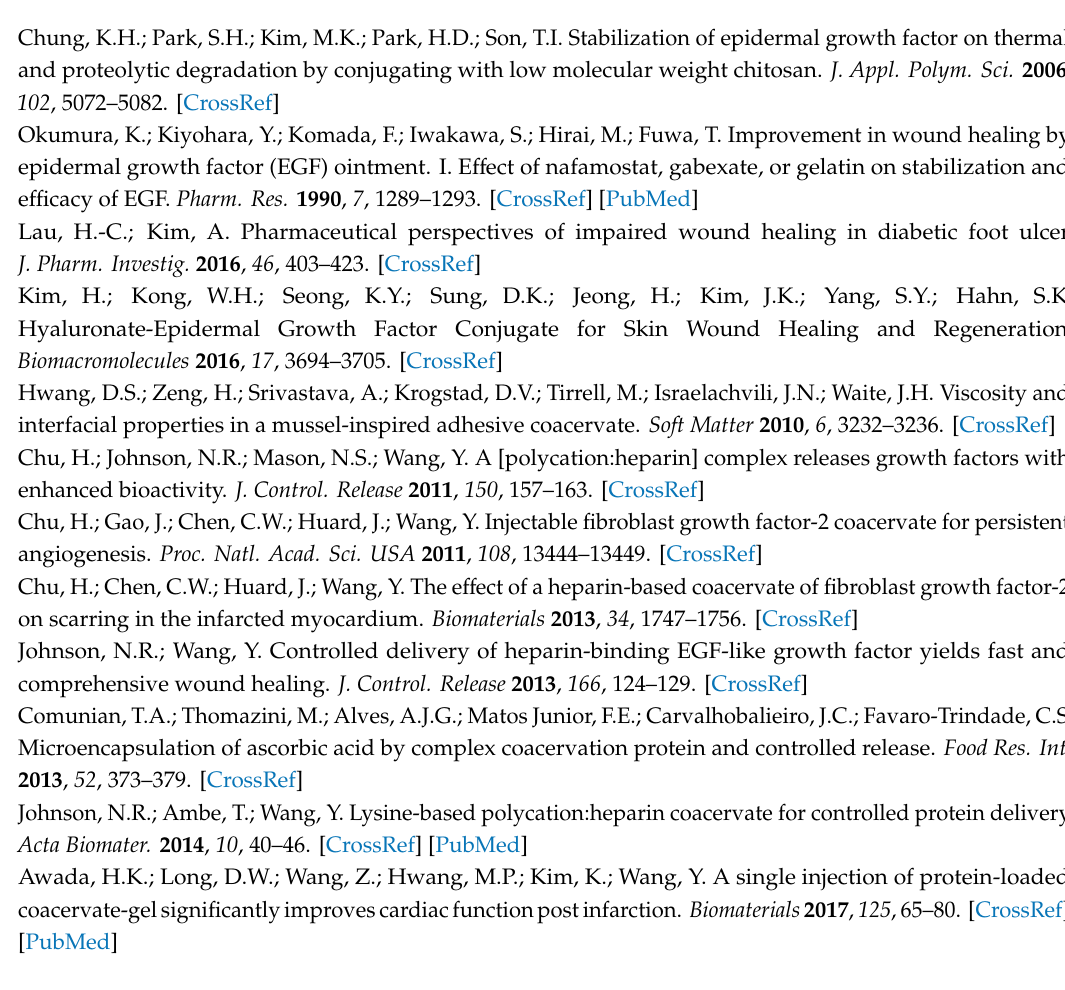
Table S1: pH dependence of the reaction between HWGA and SA at various polymer ratios. Table S2: pH dependence of the reaction between LWGA and SA at various polymer